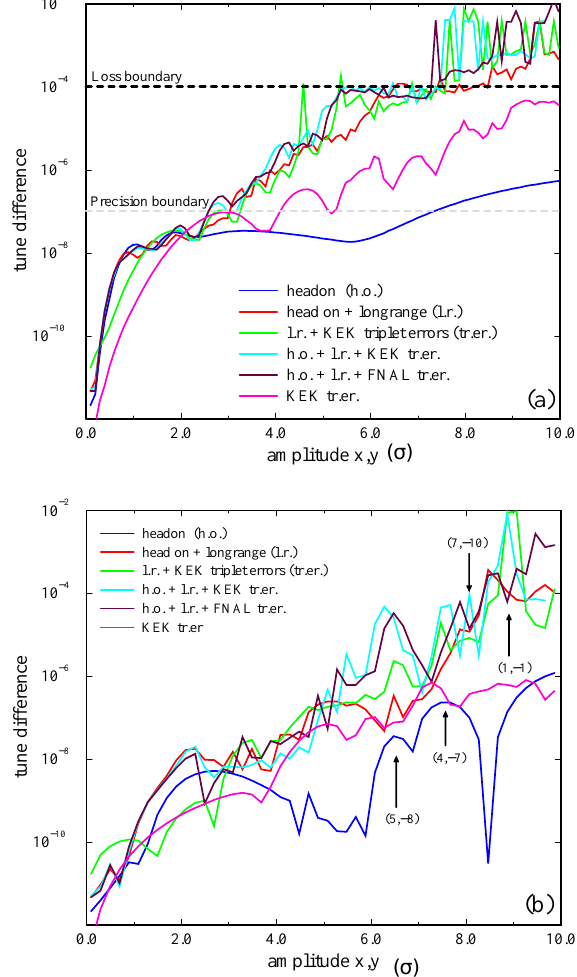
FIG. 10. (Color) The change of frequency per 500 turns (a) averaged over all initial amplitude ratios x 2 y , and (b) for a fixed initial ratio of 45 ± , as a function of the starting amplitude. Compared are the cases of head-on collisions only, head-on and long-range collisions, long-range collisions plus KEK triplet field errors, both types of collisions plus KEK triplet field errors, both types of collisions plus FNAL triplet field errors, and only KEK triplet